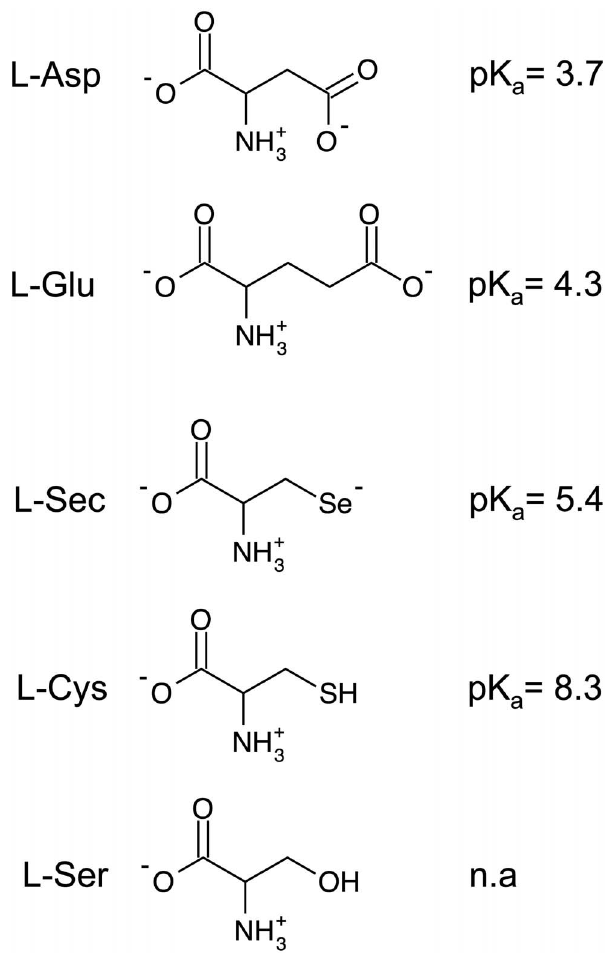
Figure 1. Structures of EAAT substrates and non-substrates. Diagrams of relevant amino acids and the associated side chain pK a s. Amino acids are depicted in their primary charge state at physiological pH. Abbreviations are: L-Asp, L-aspartate; L-Glu, L-glutamate; L-Sec, L- selenocysteine; L-Cys, L-cysteine; L-Ser, L-serine.